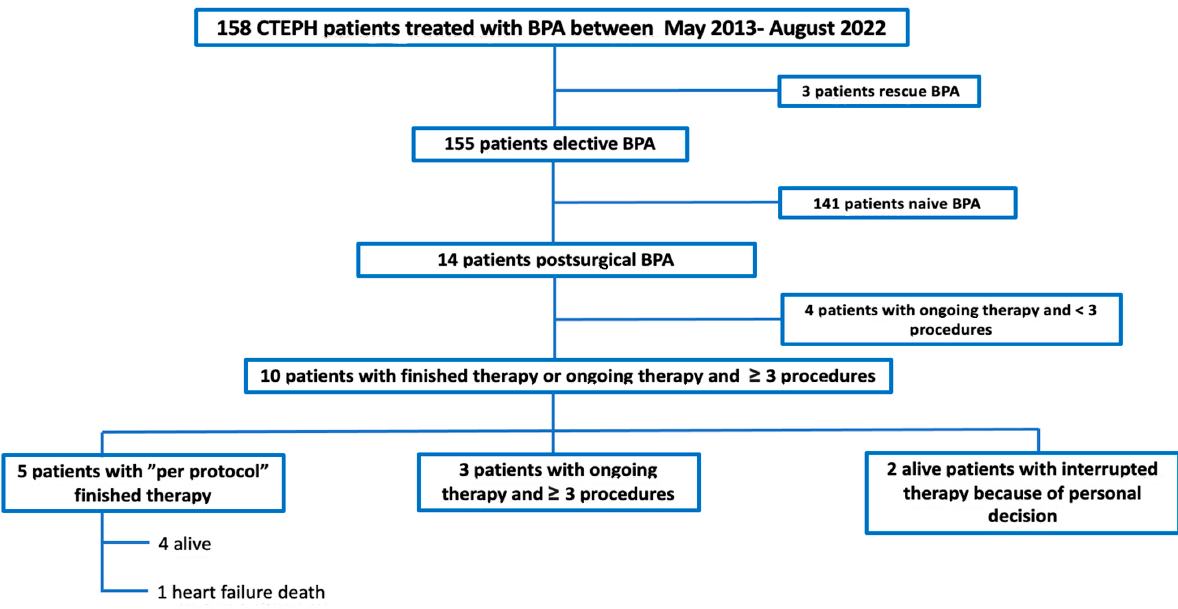
Figure 1. Flowchart of patients included in the study.